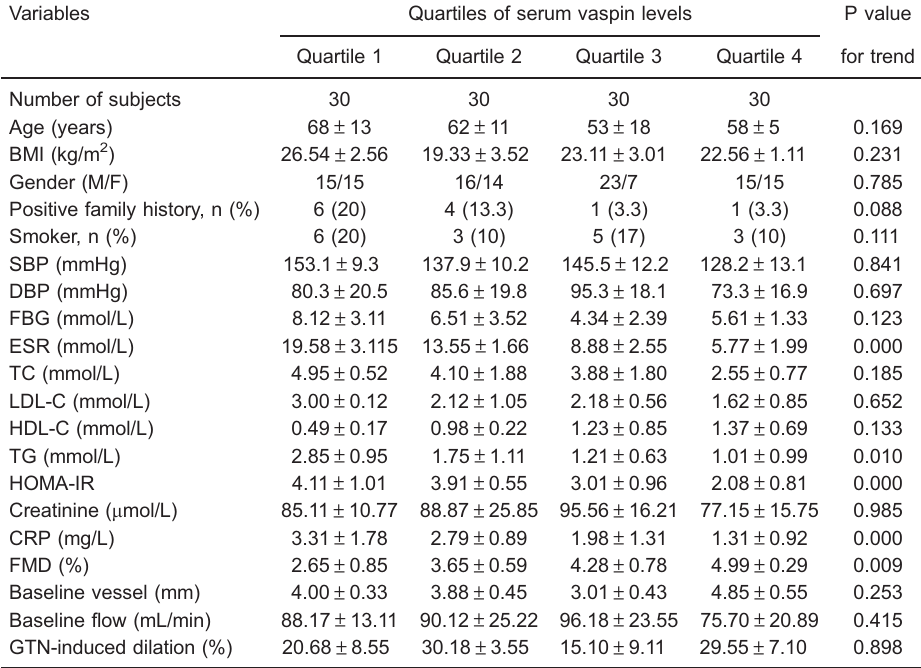
Table 2. Clinical and biochemical characteristics of patients with ankylosing spondylitis according to the quartiles of serum vaspin levels.